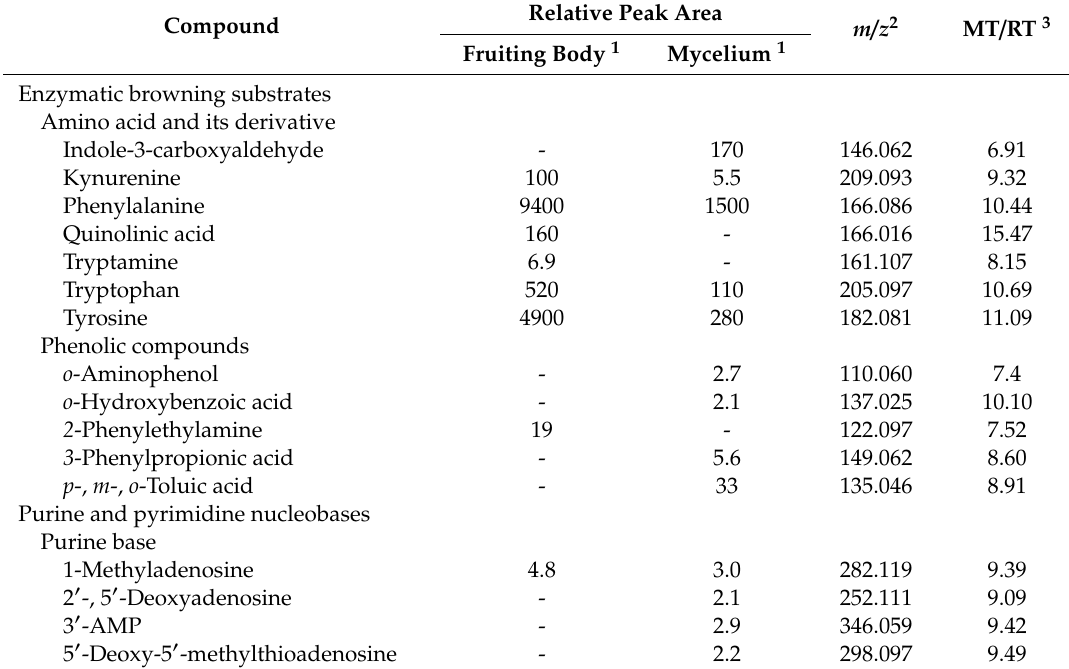
Table 2. Potential substrates in the enzymatic browning reaction in the H. erinaceus fruiting body and